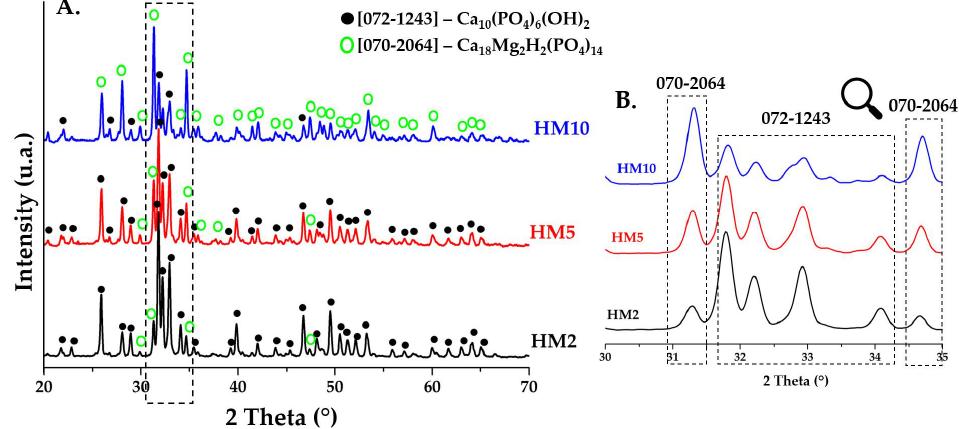
Figure 3. XRD patterns of ceramic powders obtained after calcination heat treatment at 900 °C for HM2, HM5, and HM10.